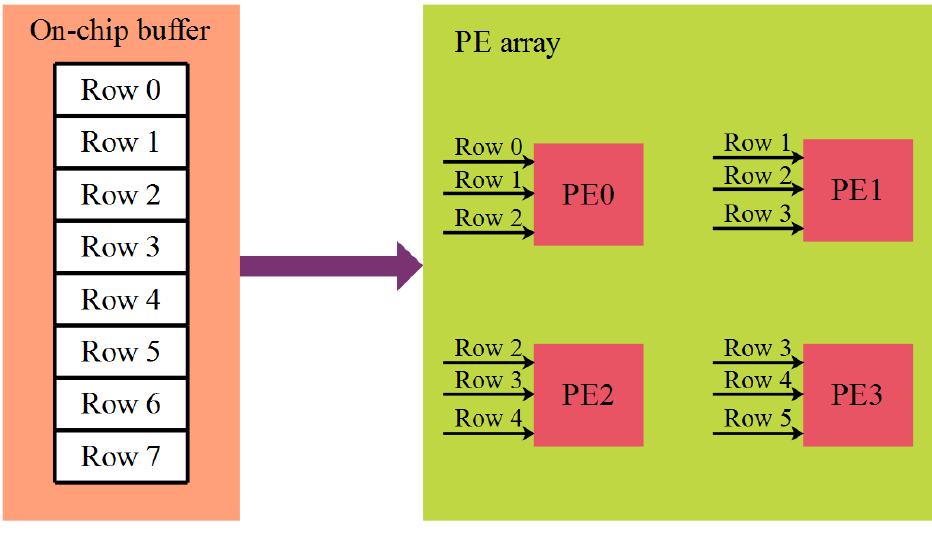
Figure 5. Row data reuse strategy.